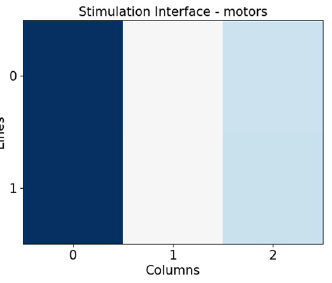
Figure 19: Representation of a couple in an LDR using the TouchYou. The man is in Brazil and uses the touch - sensitive interface, while the girl lives in France and uses the touch - stimulation